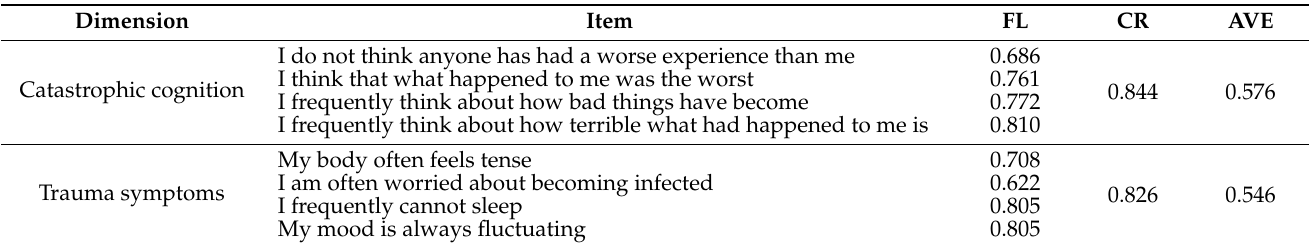
Table 1. Confirmatory factor analysis of the COVID-19 victimization experience scale.